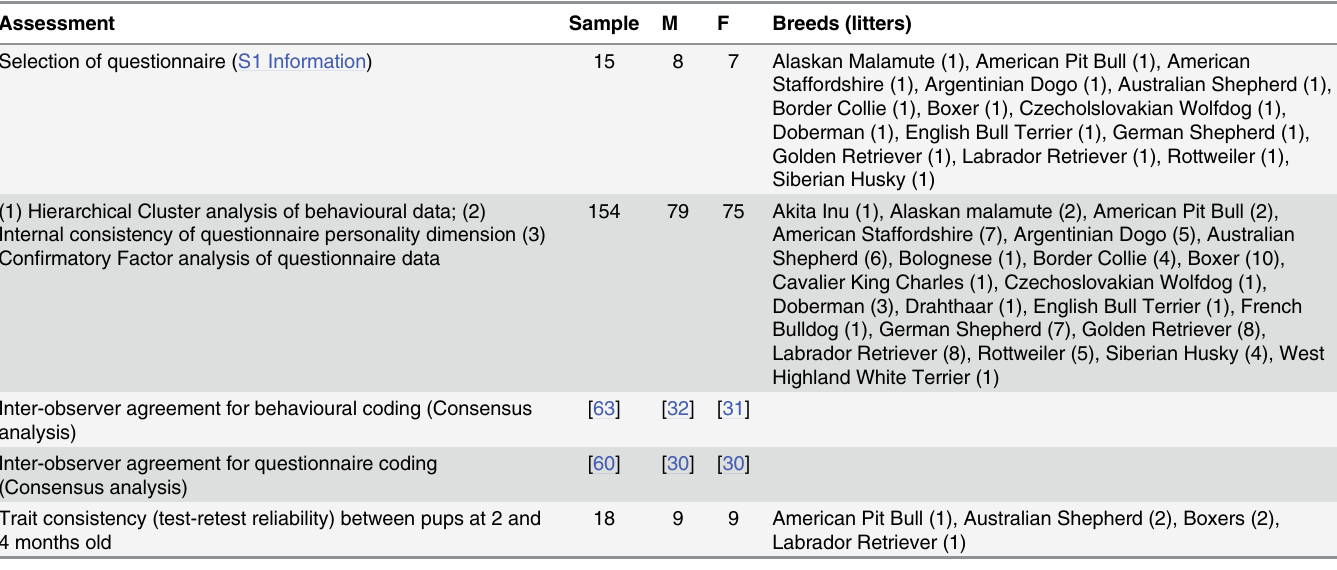
Table 1. Summary of the analysis carried out and details on sample size, breed, sex (M, F), number of litters from which the sample was taken associated to each